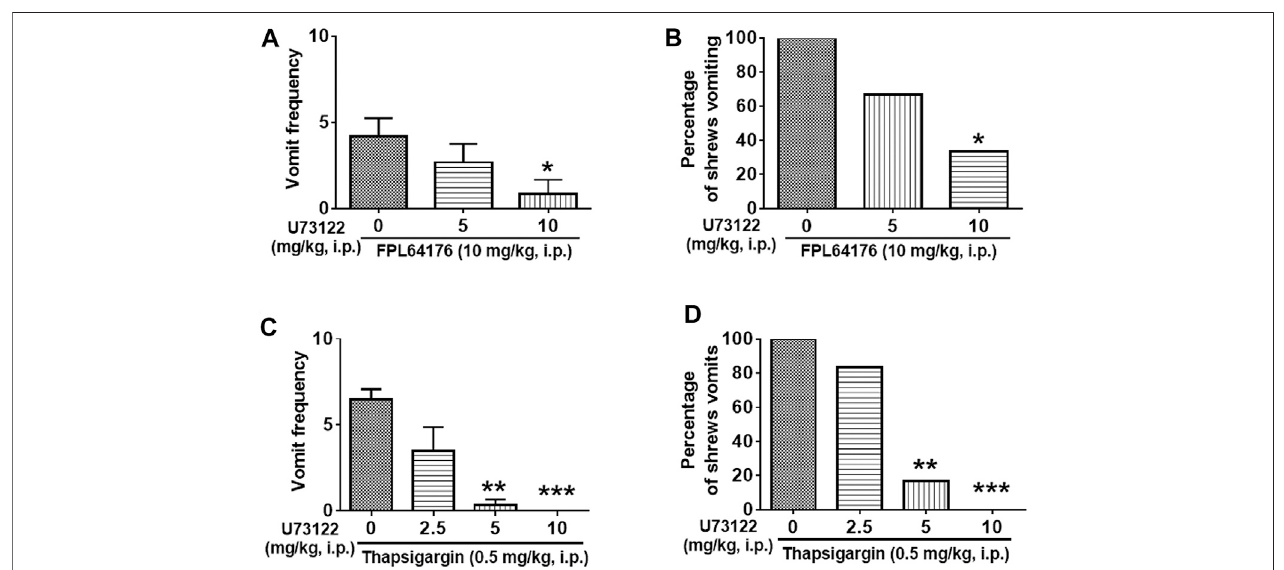
FIGURE 9 | The antiemetic effects of the selective plc inhibitor U73122 against vomiting caused by Ca 2+ channel regulators: the LTCC agonist FPL64176 and the SERCA inhibitor thapsigargin. Varying doses of U73122 (i.p.) were injected to different groups of shrews 30 min prior to an injection of a fully effective emetic dose of FPL64176 (10 mg/kg, i. p., n (cid:1) 6) (A,B) , or thapsigargin (0.5 mg/kg, i. p., n (cid:1) 6) (C,D) . Emetic parameters were recorded for the next 30 min (A,C) The frequency of emesis was analyzed with Kruskal-Wallis non-parametric one-way ANOVA followed by Dunnett ’ s post hoc test and presented as mean ± SEM. (B,D) Percentage of shrews vomiting was analyzed with chi-square test and presented as the mean. * p < 0.05, ** p < 0.01, *** p < 0.001 vs. 0 mg/kg.